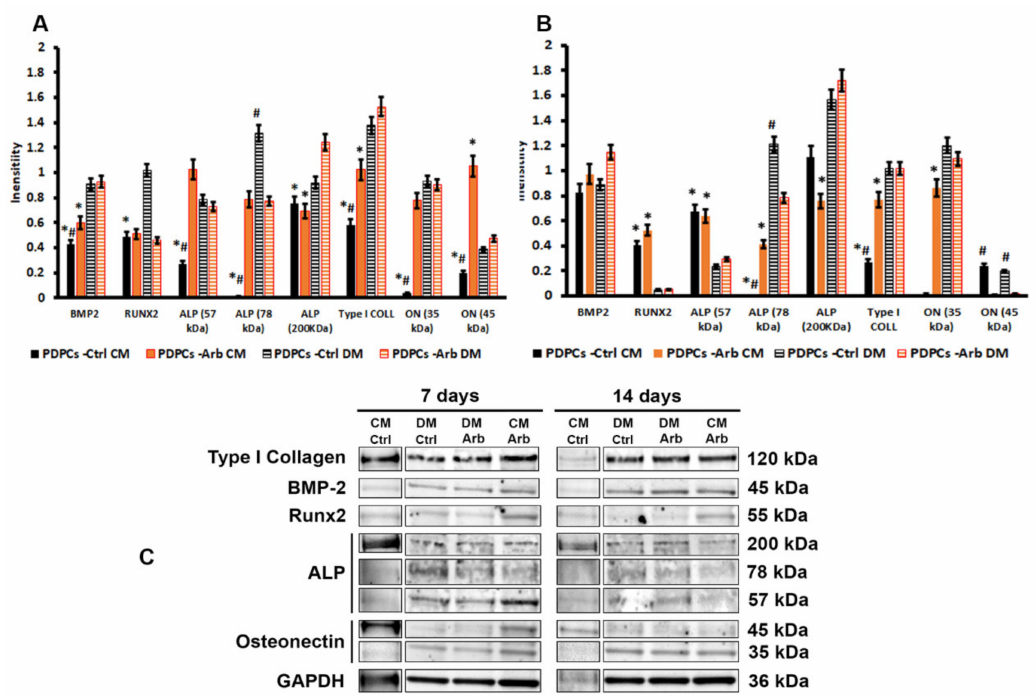
Figure 3. Histograms depicting densitometric quantitation of western blotting at 7 ( A ) and 14 ( B ) days of culture of the gel presented in ( C ): results are expressed as intensity normalized to GAPDH. Asterisks indicate significant di ff erences between CM and DM ( p < 0.05); # indicates significant di ff erences between ctrl and arbutin ( p <